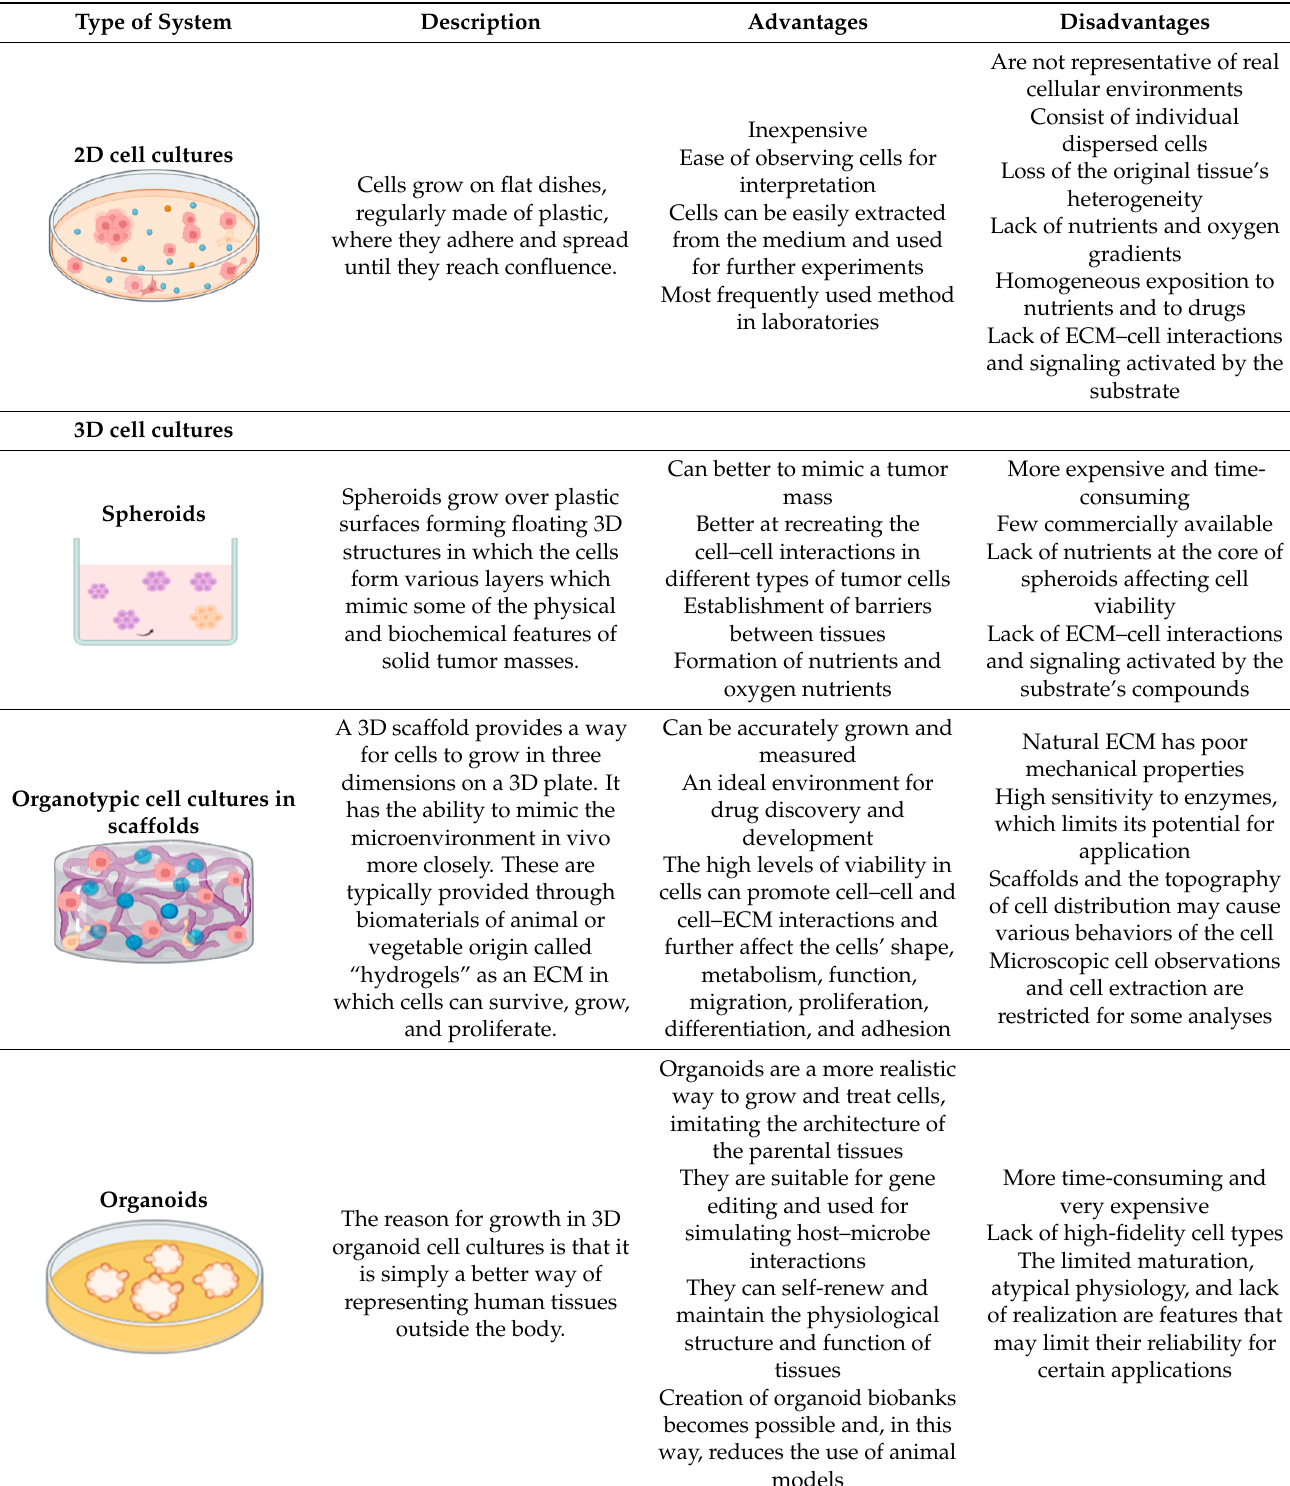
Table 2. Comparison between 2D versus 3D cell cultures: Advantages and disadvantages.